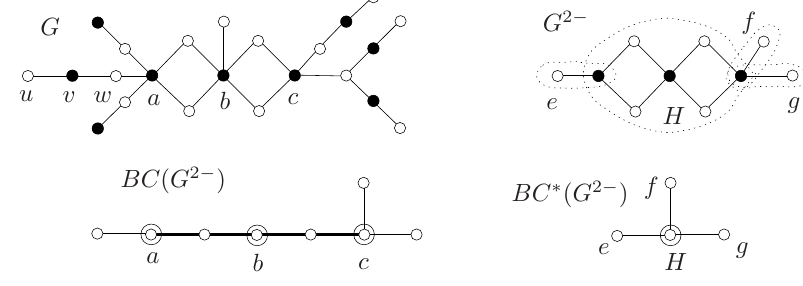
Fig. 5: A graph for which BC ∗ ( G 2 − ) is not a path. Circled vertices in BC ( G 2 − ) correspond to cut vertices; in BC ∗ ( G 2 − ) they are maximal 2-edge-connected